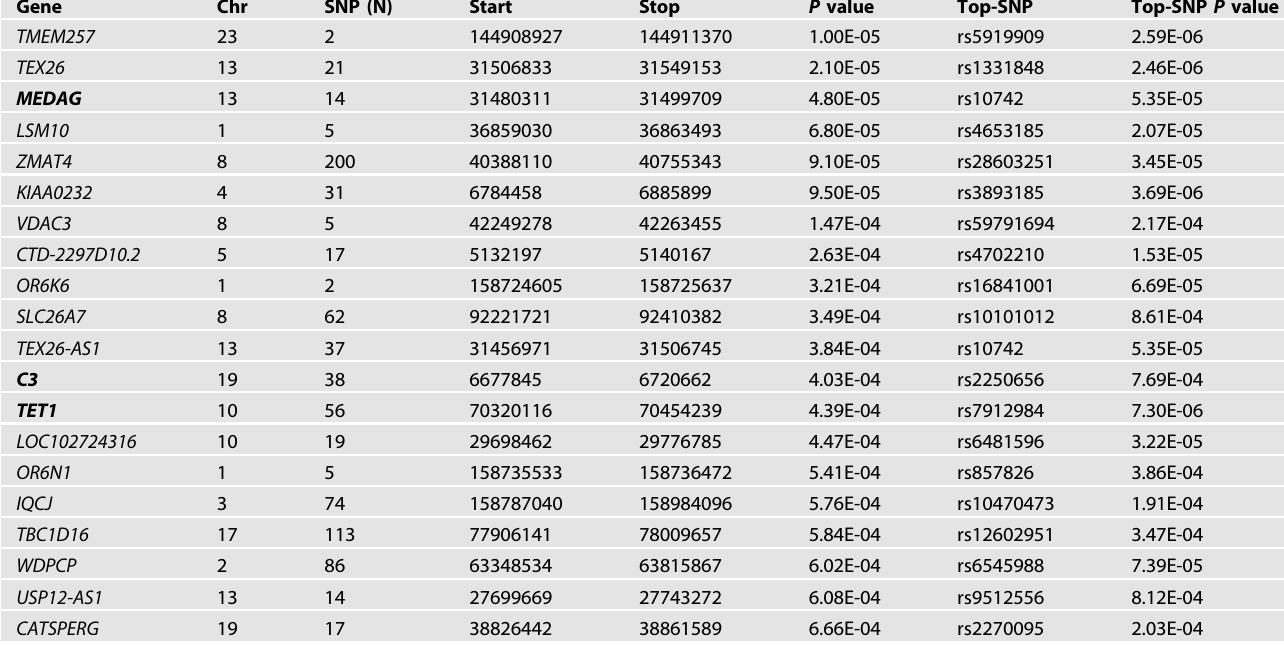
Table 2. The top 20 genes associated with depression-cognition-memory from gene-based